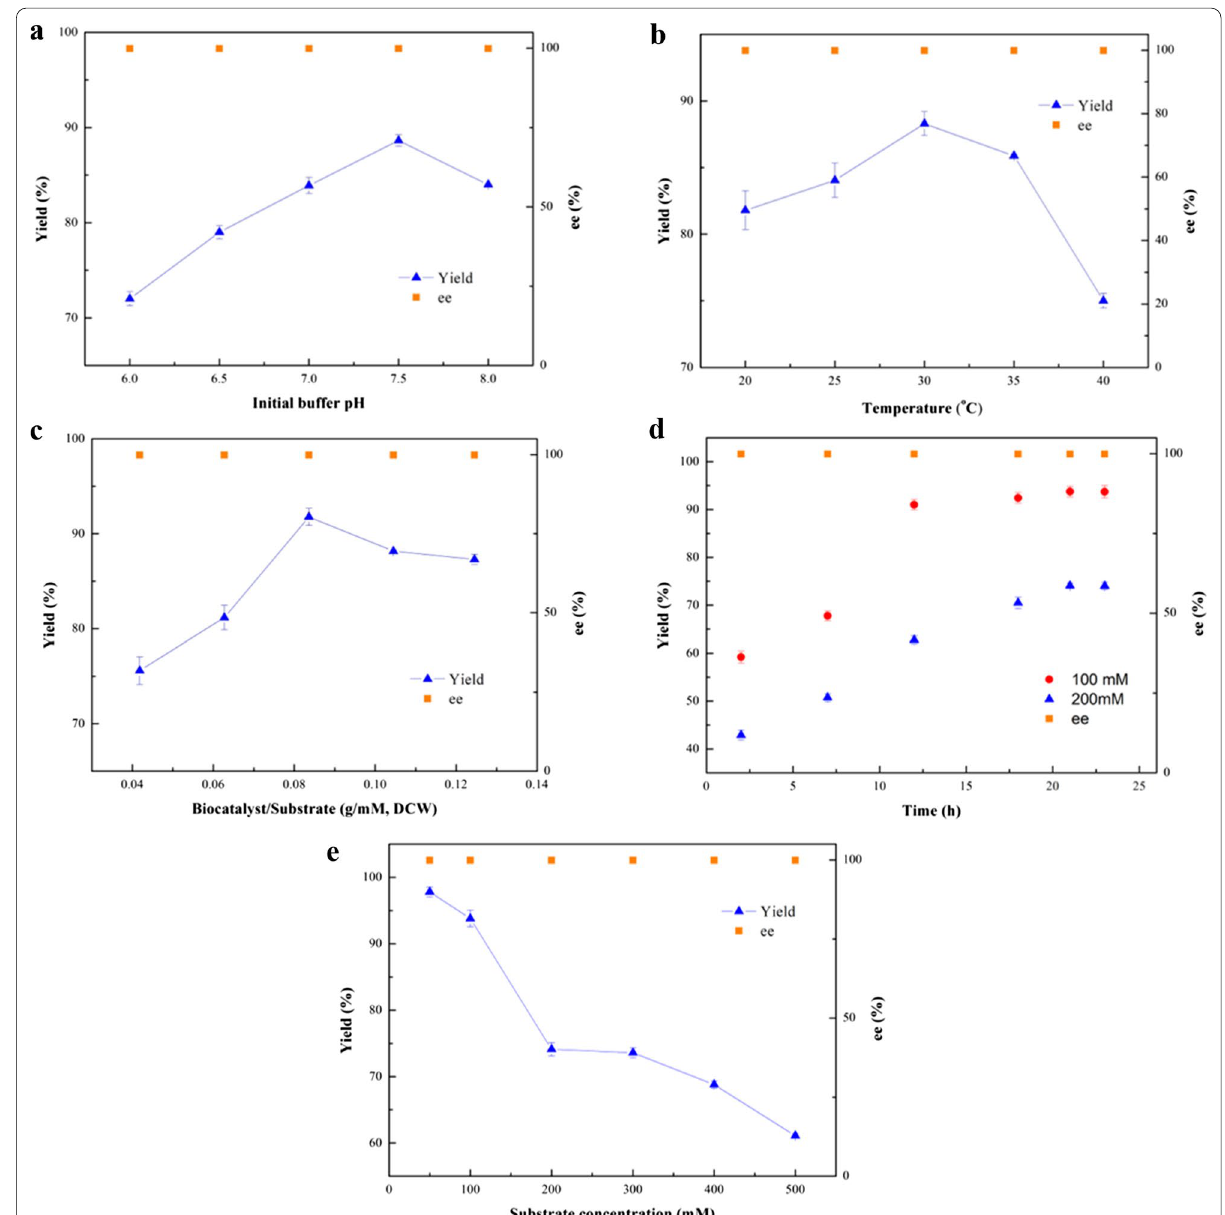
Fig. 2 Effects of key reaction parameters on the ( R )-MTF-PEL production with recombinant E. coli cells in PBS buffer medium. Reaction conditions: a Effect of initial buffer pH: 100 mM 3’-(trifluoromethyl)acetophenone, 15% (v/v) isopropanol, 10.57 g (DCW)/L recombinant E. coli cells, 30 ℃ , PBS buffer, 200 rpm, 12 h. b Effect of temperature: 100 mM 3’-(trifluoromethyl)acetophenone, 15% (v/v) isopropanol, 10.57 g (DCW)/L recombinant E. coli cells, PBS buffer (pH 7.5), 200 rpm, 12 h. c Effect of the ratio of biocatalyst to substrate concentration: 100 mM 3’-(trifluoromethyl)acetophenone, 15% (v/v) isopropanol, various recombinant E. coli cells as biocatalyst, PBS buffer (pH 7.5), 30 ℃ , 200 rpm, 12 h. d Time course of ( R )-MTF-PEL production with recombinant E. coli cells in PBS buffer medium: 15% (v/v) isopropanol, PBS buffer (pH 7.5), 30 ℃ , 200 rpm, 8.6 g (DCW) /L recombinant E. coli cells under 100 mM substrate concentration (Black circle), 17.6 g (DCW) /L recombinant E. coli cells under 200 mM substrate concentration (Black up-pointing triangle). e Effect of substrate concentration on the ( R )-MTF-PEL production with recombinant E. coli cells: 15% (v/v) isopropanol, 0.086 g (DCW)/mM recombinant E. coli cells, PBS buffer (pH 7.5), 30 ℃ , 200 rpm, 21